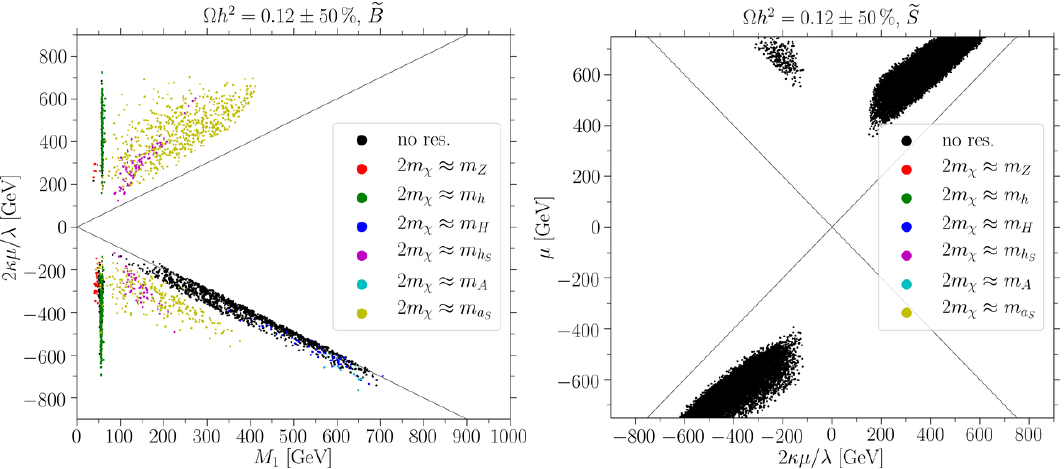
Figure 4 . Left: points from our parameter scan with bino-like lightest neutralino and relic density (cid:10) h 2 = 0 : 12 (cid:6) 50 % in the bino mass ( M 1 ) | singlino mass (2 (cid:20)(cid:22)=(cid:21) ) plane. Right: points with singlino-like lightest neutralino in the singlino mass (2 (cid:20)(cid:22)=(cid:21) ) | Higgsino mass ( (cid:22) ) plane. For both panels, the color code indicates points where the lightest neutralino can pair-annihilate resonantly with the s -channel mediator with mass (cid:25) 2 m (cid:31) as indicated in the legend.